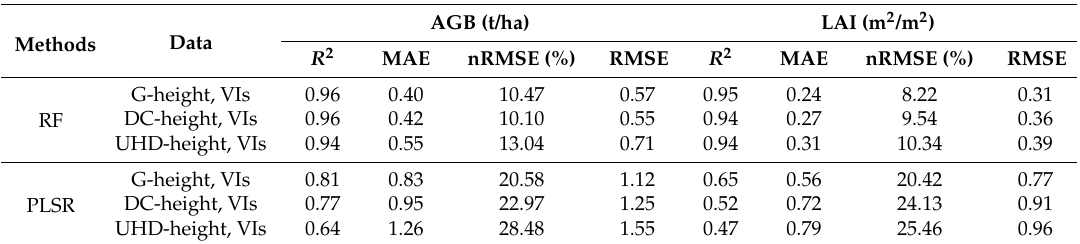
Table 8. Estimates of leaf area index and above-ground biomass based on crop height, using all vegetation indices and using partial least square regression and random forest methods (calibration